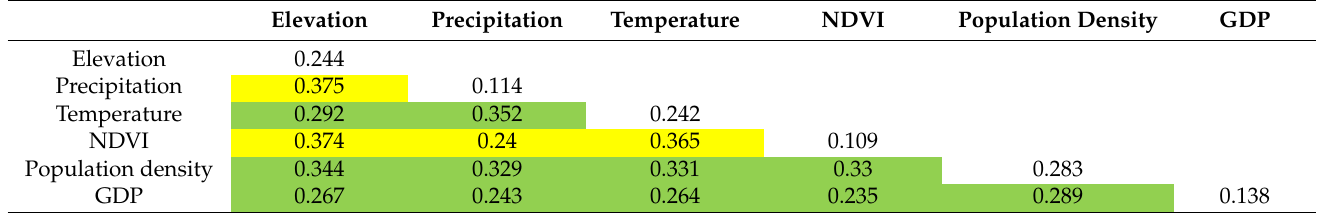
Table 7. The explanatory power of factor